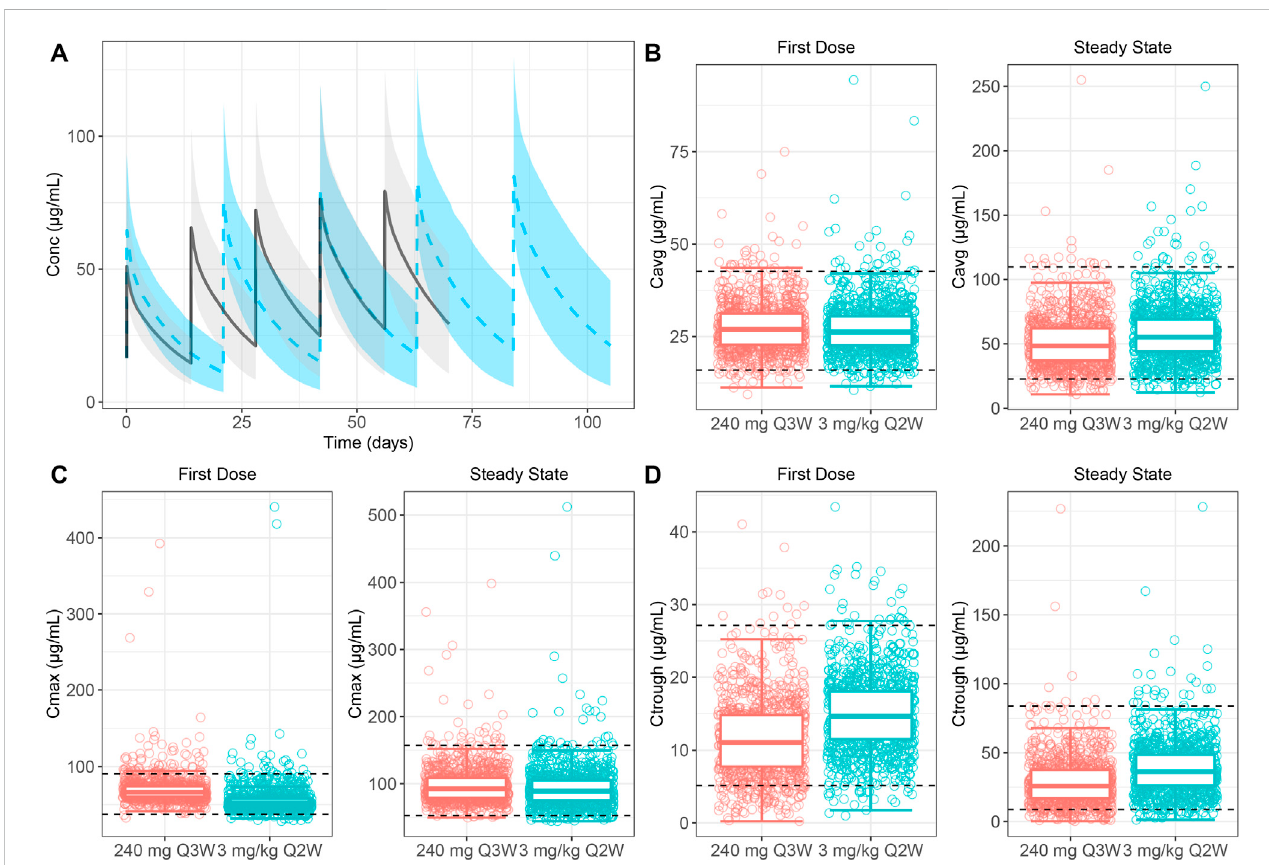
FIGURE 2 (A) Simulated concentration – time pro fi les of fi ve doses for 3 mg/kg Q2W and 240 mg Q3W dosing regimens. The 3 mg/kg Q2W dosing regimen is represented by black lines (median) and grey shading (95% con fi dence interval). The 240 mg Q3W dosing regimen is represented by dashed blue lines (median)andblueshading(95%con fi denceinterval). (B – D)(B) C avg , (C) C max and (D) C trough of240 mgQ3Wcontainedwithinthe2.5thand97.5thpercentiles of3 mg/kgQ2Watthe fi rstdoseandsteadystate.Horizontaldashedlinesrepresentthe2.5thand97.5thpercentilesof3 mg/kgQ2Wexposures.Forthe fi rst dose and steady state of C avg , 95% of exposure from dosing 240 mg Q3W is contained within the horizontal lines. For the